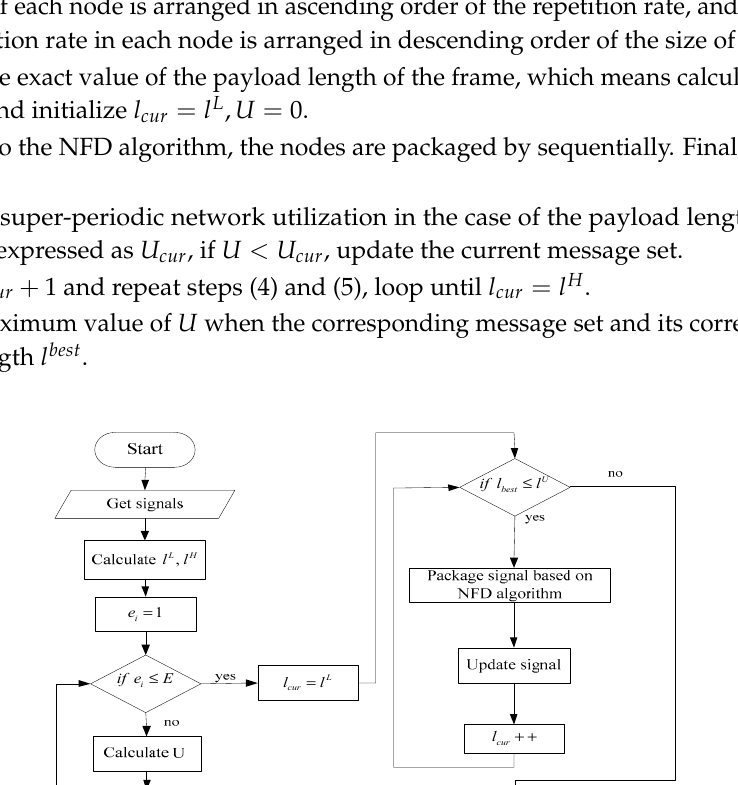
Figure 4. Frame schedule for FlexRay.